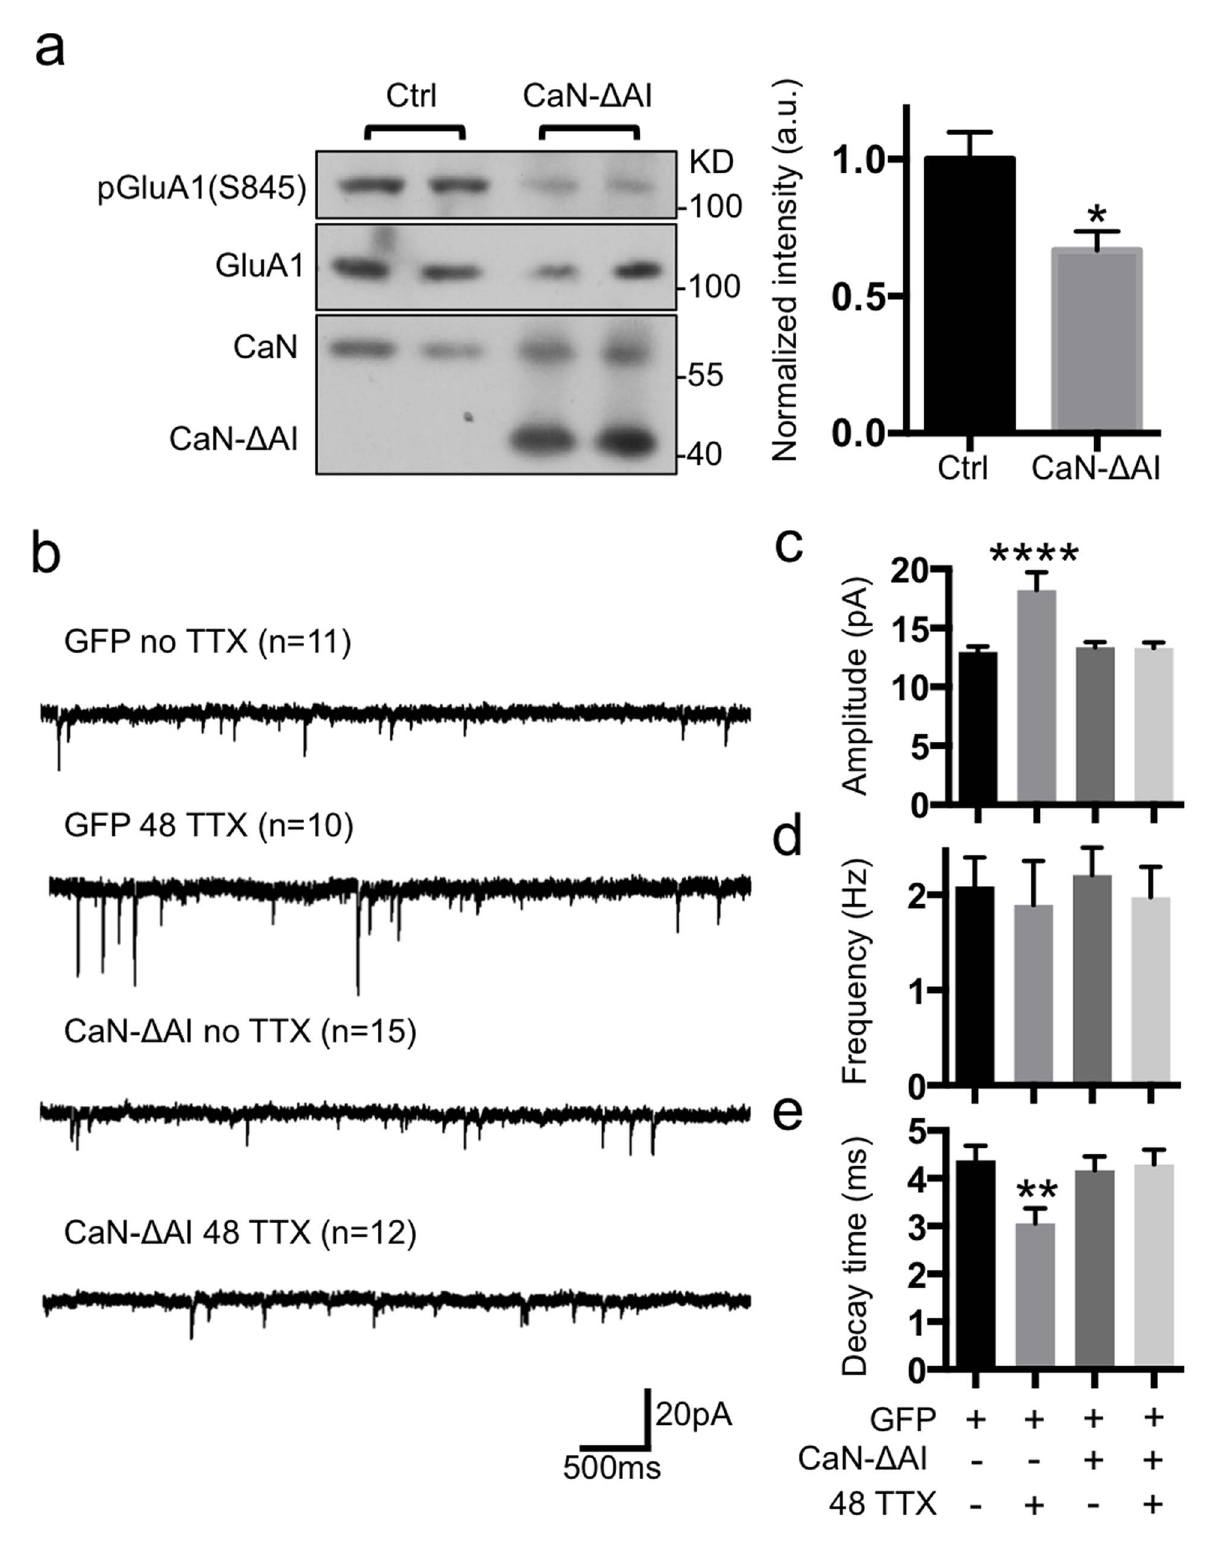
Figure 6. Constitutively active calcineurin mutant inhibited TTX-induced synaptic scaling. (a) Representative immunoblots showing overexpressing GluA1 with or without truncated mutant calcineurin (CaN- D AI) in HEK293 cells and a summary graph of pGluA1(S845) levels in each condition ( n =3 experiments, * p , .05, unpaired two-tailed Student’s t test). (b) Representative traces of mEPSCs in each condition ( n =number of cells). (c) Average mEPSC amplitude (**** p , .0001, one-way ANOVA, uncorrected Fisher’s LSD). (d) Average mEPSC frequency. (e) Average decay time (peak to 10%) (** p , .01, one-way ANOVA, uncorrected Fisher’s LSD). doi:10.1371/journal.pbio.1001900.g006 PLOS Biology |